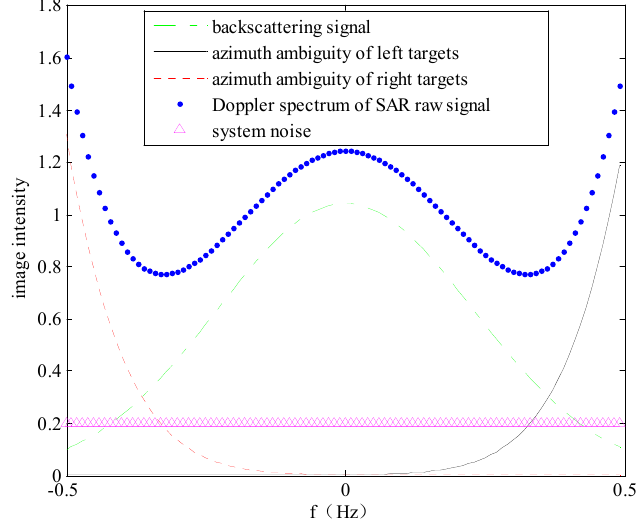
Figure 1. Schematic of the Doppler spectrum of synthetic aperture radar (SAR) raw signal and its various components.